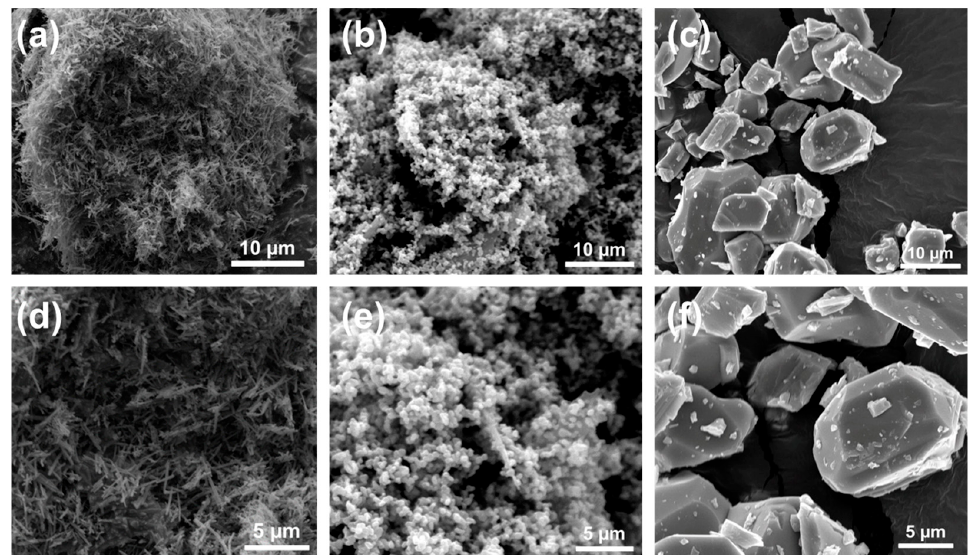
Figure 3. FE-SEM images of ( a , d ) FV500, ( b , e ) FV600, and ( c , f ) FV700 at the magnifications of 10 μ m and 5 μ m, respectively.